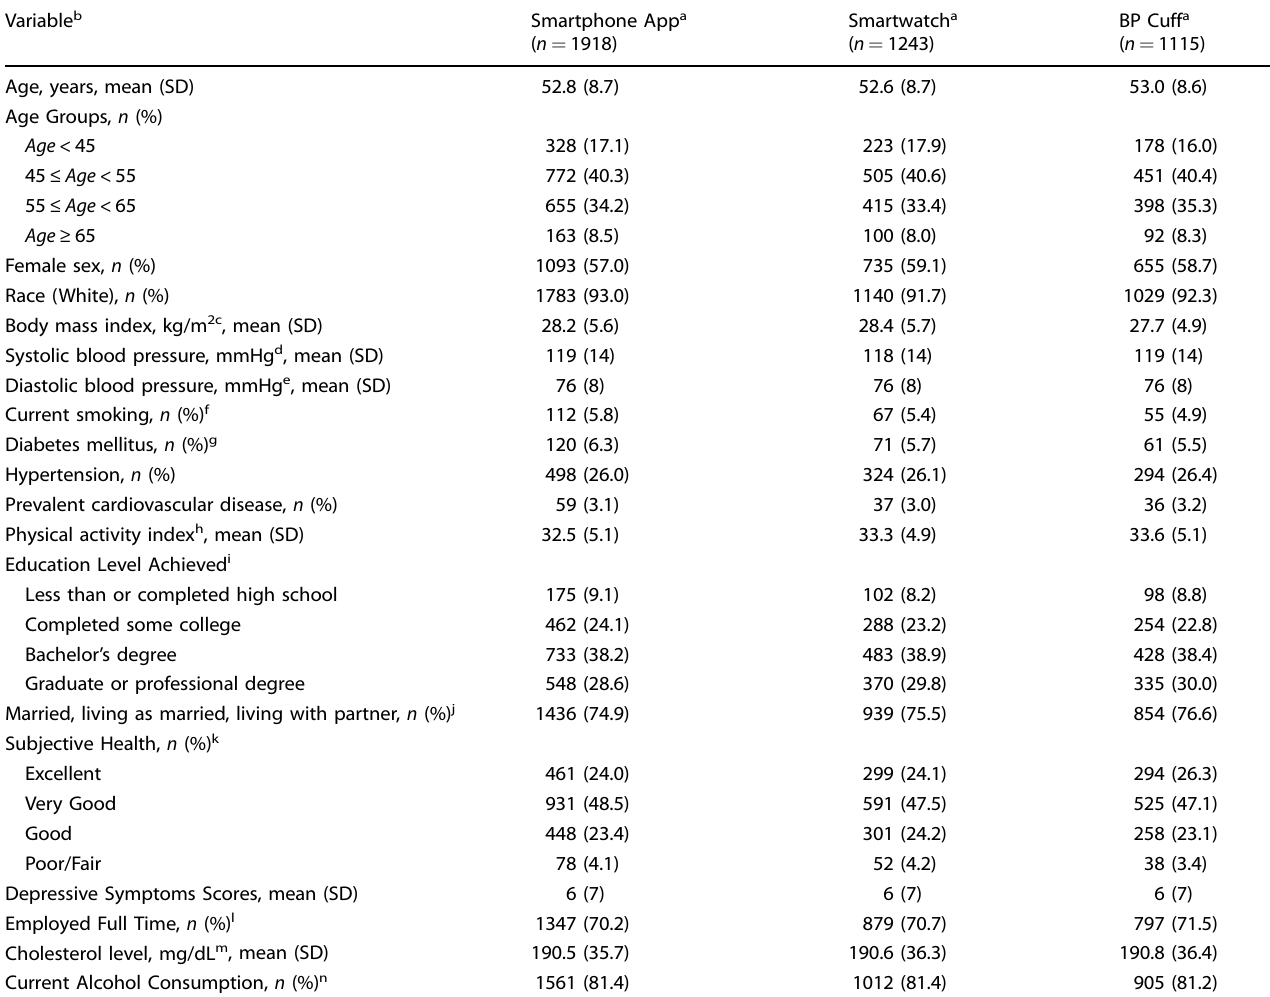
Table 1. Characteristics of participants in eFHS: Smartphone App Use, Smartwatch Use, and Digital BP Cuff Use. Variable